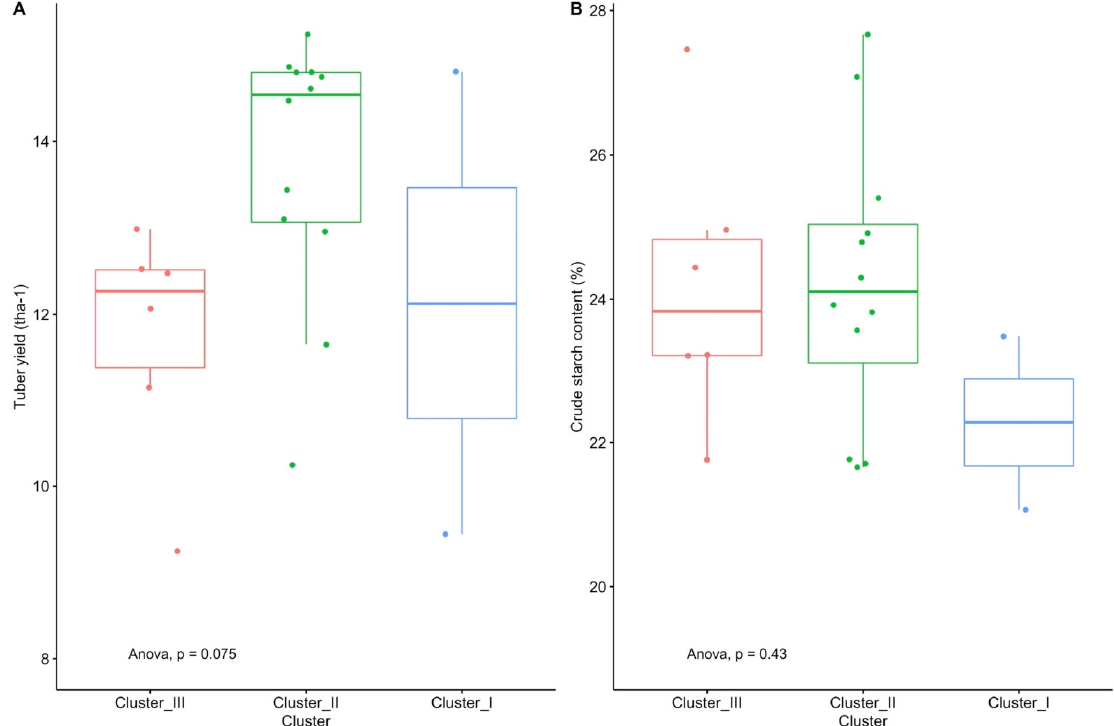
Figure 4. Multiple comparisons test of cluster means of white yam genotypes based on starch pasting properties for tuber yielding potential and crude starch content estimated by AMMI model analysis. ( A ) = cluster mean comparisons test for tuber yielding potential and ( B ) = cluster mean comparisons test for crude starch content.